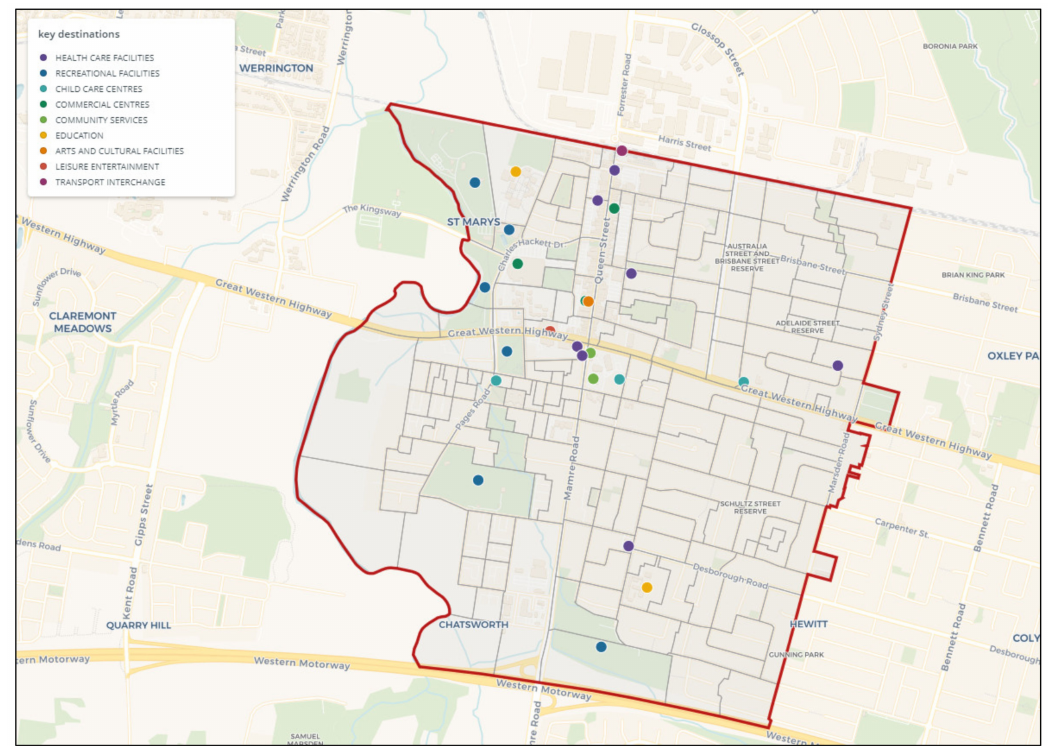
Figure 3. The case study boundary and main